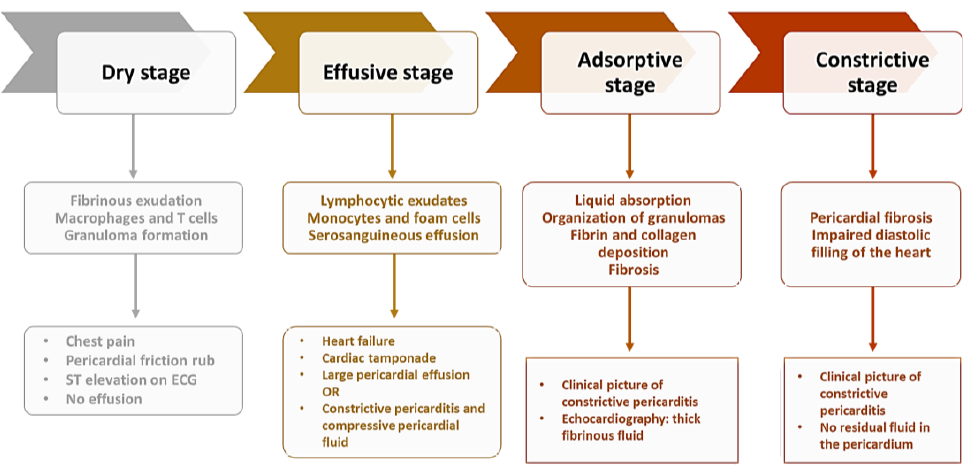
Figure 2. Stages of constrictive pericarditis (adapted after [105]).